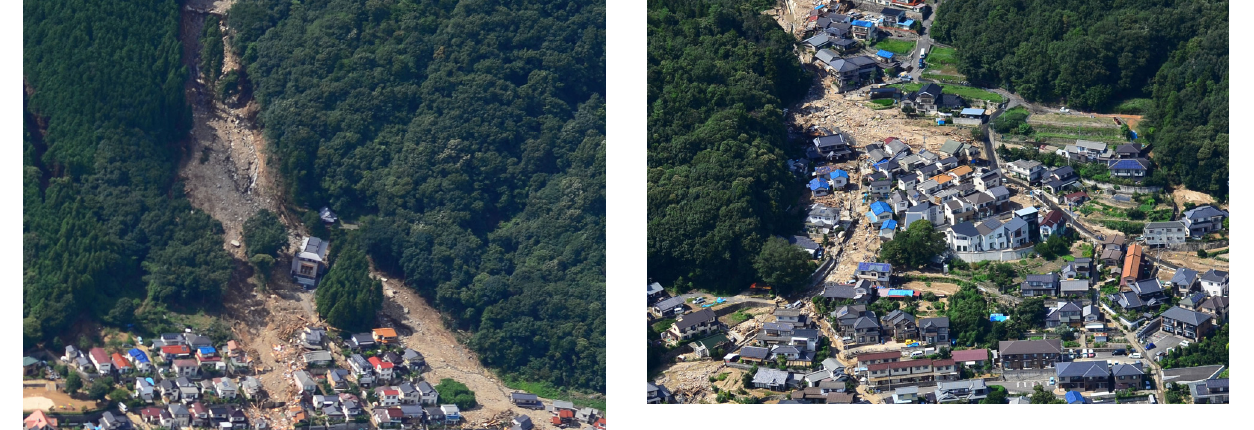
Figure 18 . Asaminami Ward green well district